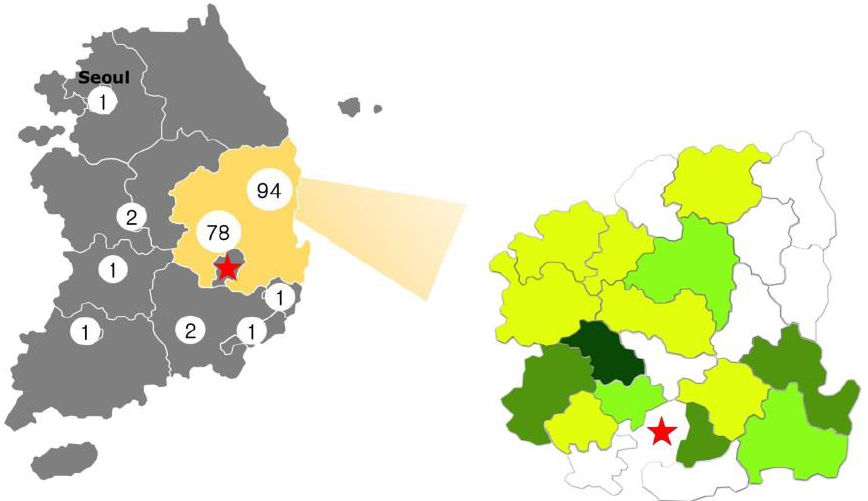
Figure 2. Patient residential areas and the number of patients. The red star indicates the main city, Daegu, with the first local pediatric palliative care center. The yellow zone indicates nearby areas (Gyeongsangbuk-do). Color severity is associated with the number of patients. Dark-green implies > 20 patients, green > 10, light-green > 5, and yellowish-green < 5. The gray zone indicates other areas where patients reside.